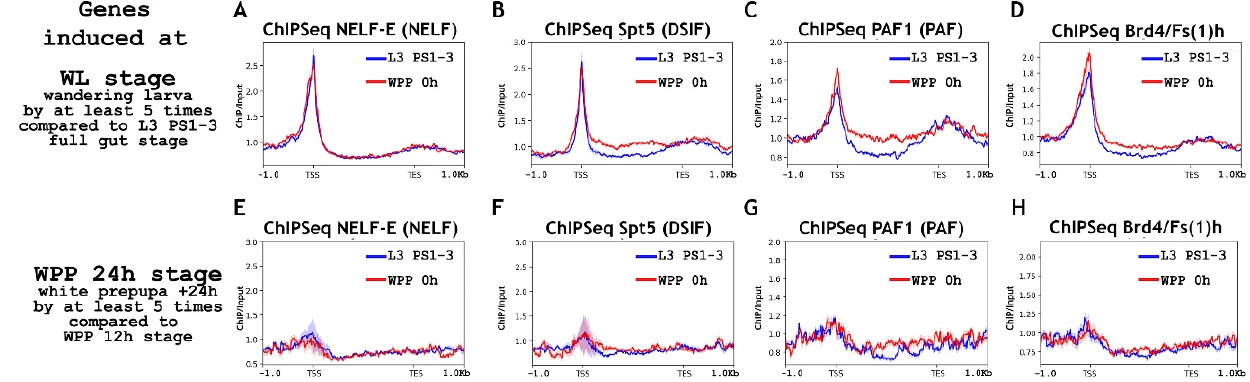
Figure 6. Average binding profiles of NELF-E (NELF), Spt5 (DSIF), PAF1 (PAF), and Bdr4/Fs(1)h on genes induced at Drosophila puparium formation (“WL” wandering larva) and 24 h after puparium formation (“WPP 24 h” white prepupa 24 h). Average distribution of ( A ) NELF-E (NELF complex), ( B ) Spt5 (DSIF complex), ( C ) PAF1 (PAF complex), and ( D ) Brd4/Fs(1)h binding across the genes induced in wandering larvae L3 (WL stage: wandering larva) (total 303 genes/852 transcripts). Average distribution of ( E ) NELF-E (NELF complex), ( F ) Spt5 (DSIF complex), ( G ) PAF1 (PAF complex), and ( H ) Brd4/Fs(1)h binding across the genes induced 24 h after puparium formation (WPP 24 h stage: white prepupa +24 h) (total 62 genes/108 transcripts). Pools of “WL genes” and “WPP 24 h genes” were selected according to the common rule, to be induced at least five times compared with “L3 PS1-3 full gut” and “WPP 12 h APF” stages, respectively. ChIP-Seqs were performed on the material of whole larvae of L3 PS1-3 full gut stage (blue line), white prepupae 0 h after puparium formation (WPP, red line) and prepupae 10 h after puparium formation (WPP 10 h, green line). Protein binding levels were calculated as an enrichment (ratio of the corresponding ChIP-Seq signal to the input DNA). Average profiles were generated using the metagene mode (introns were ignored and gene bodies were scaled to 2 kb) and calculated as the median of the protein binding signal. Average profiles of the RNA-seq signal were calculated as the mean level. The standard error appears on the graphs as a lighter area around the main line of the profiles. Abbreviations: L3 PS1-3: full gut stage of larva L3; WPP 0 h: white prepupa; TSS: transcription start site; TES: transcription end site.